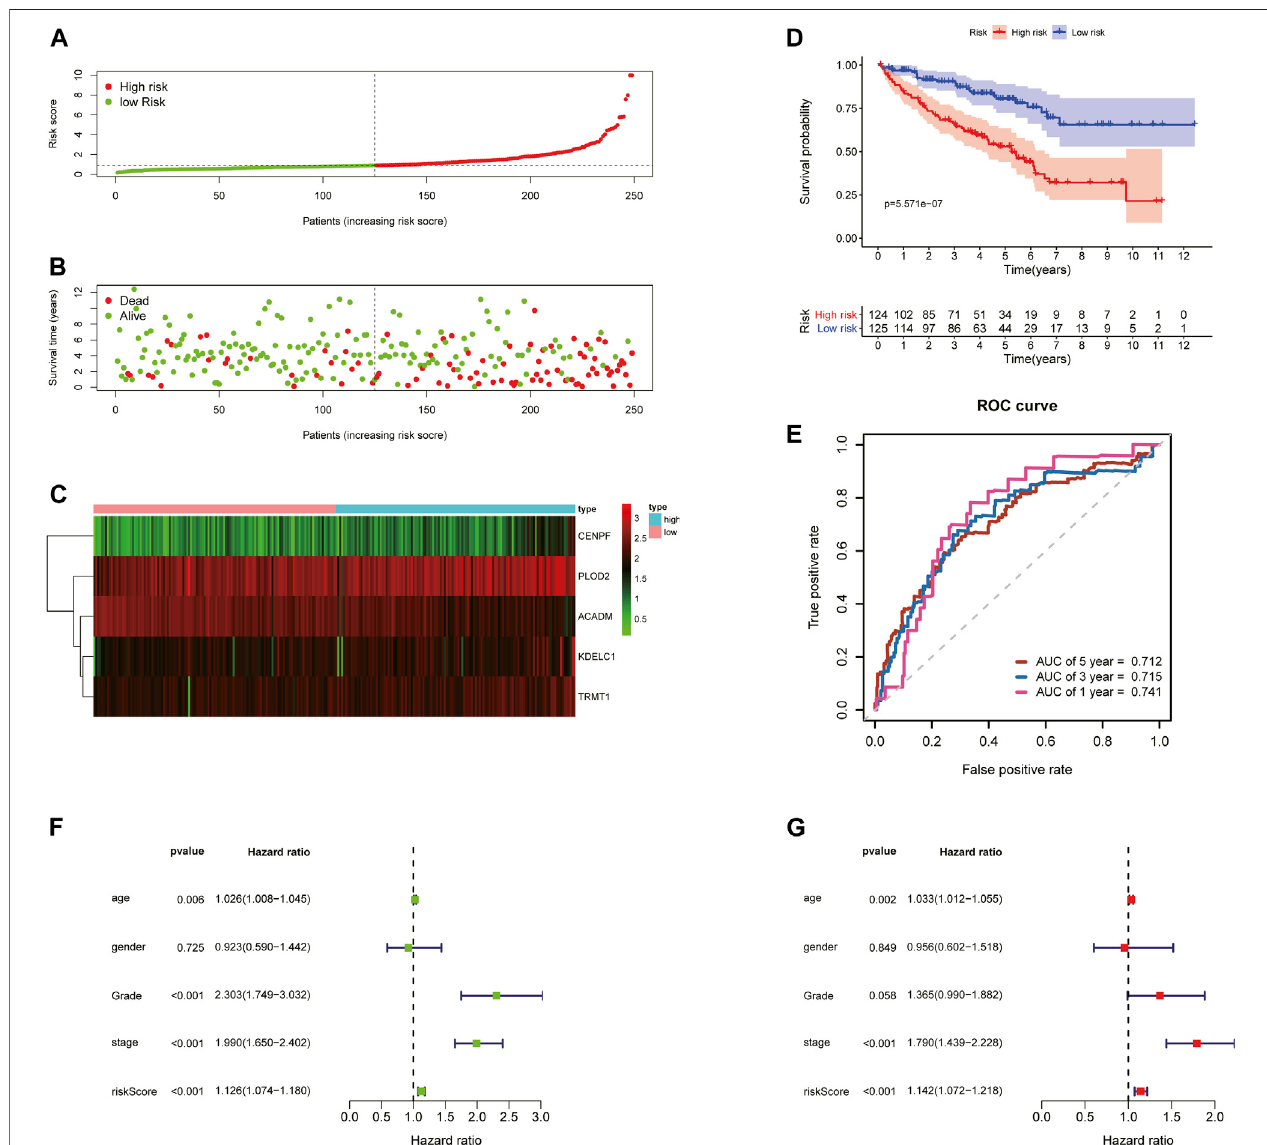
FIGURE 4 | Risk score analysis of the 5-gene signature based on SARS-CoV-2 – related genes in the testing set. (A – C) Distribution of risk scores, OS status, and geneexpressionofmodelgenes; (D) Kaplan – Meiercurvesofthehigh-andlow-risksubgrouppatients; (E) Time-dependentROCcurvesforpredicting1-,3-,and5-year OS; (F) Univariate and (G) multivariate Cox regression analyses in the testing